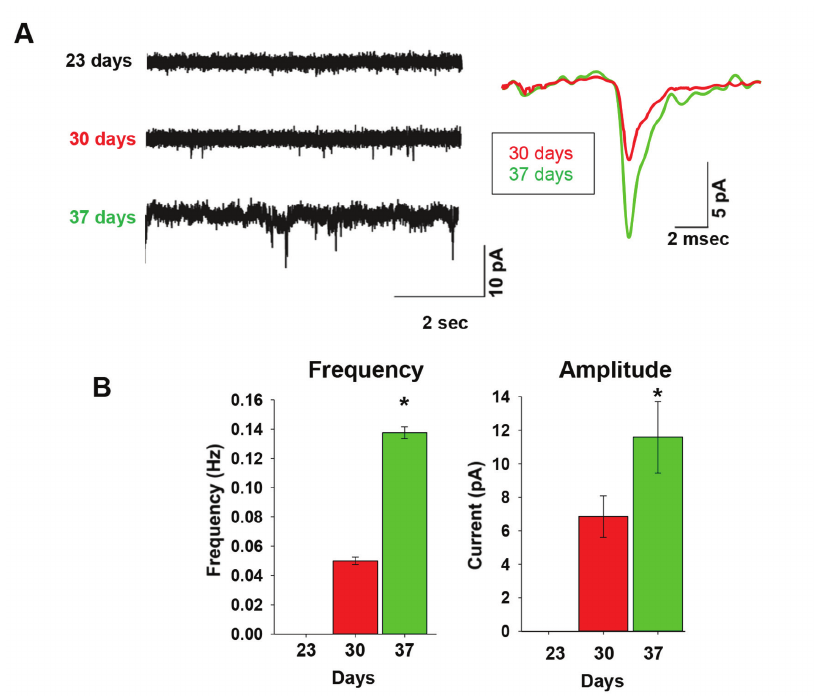
Figure 4. Voltage clamp recordings of spontaneous synaptic activity. ( A ) Representative traces for spontaneous synaptic currents recorded in voltage clamp mode at -60 mV for days 23, 30 and 37. ( B ) Analysis of spontaneous synaptic currents frequency (Hz) and amplitude (pA). Sample size: n=19 at day 23; n=18 at day 30; n=23 at day 37. Values are mean ± SEM. *P<0.05,